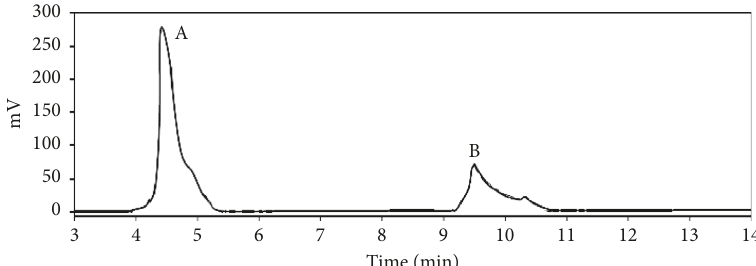
Figure 5: Peptide mapping of fraction I from COASM separated by RP-HPLC.